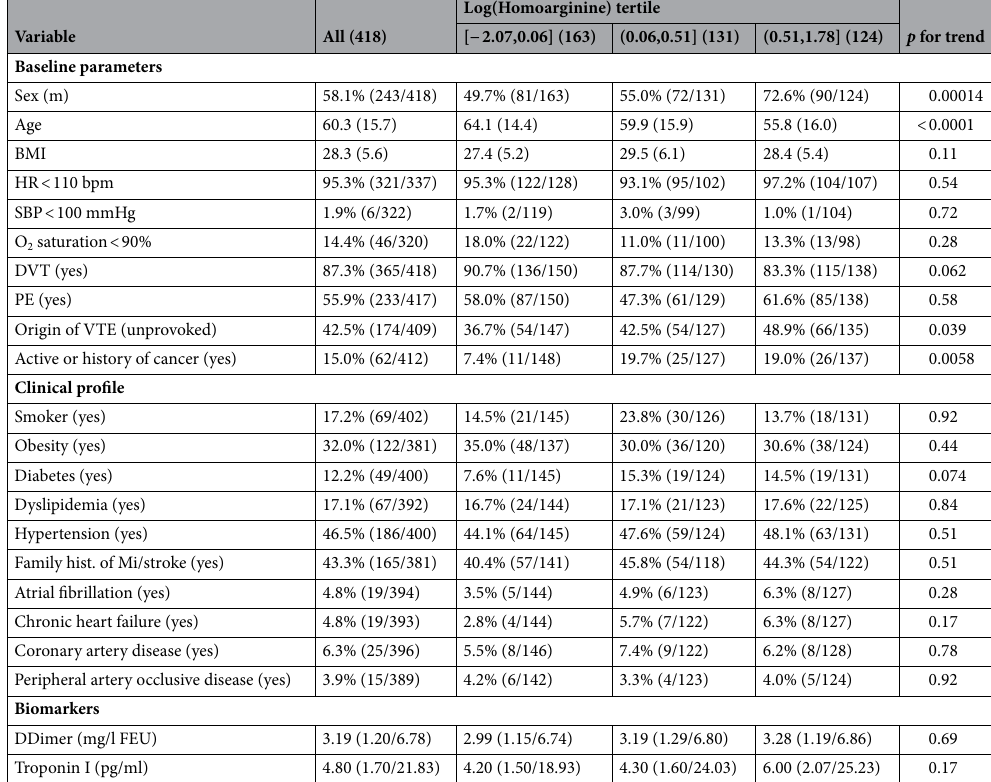
Table 2. Variables by tertiles of log(Homoarginine) in the cases only. BMI body mass index, HR heart rate, SBP systolic blood pressure, DVT deep vein thrombosis, PE pulmonary embolism, VTE venous